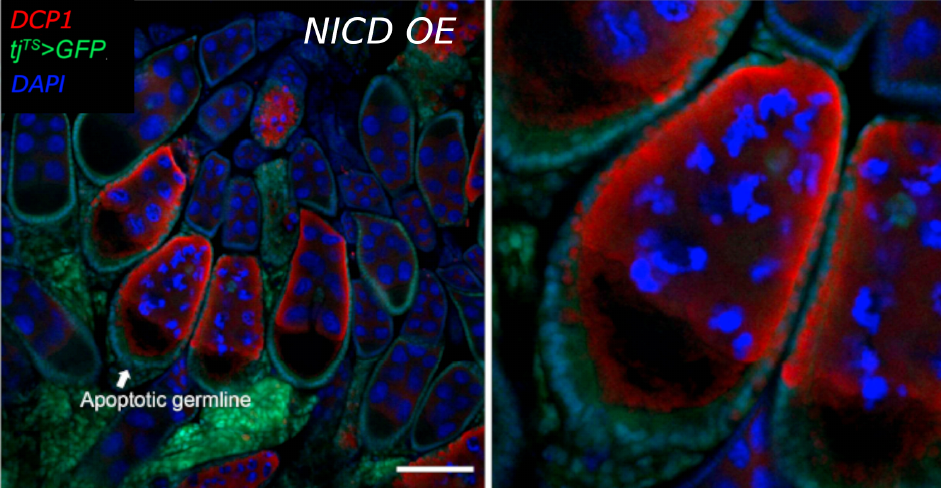
Figure A6. Germline apoptosis occurs following NICD overexpression in follicle cells. Confocal image (left) of an ovary from the NICD OE condition. Follicle cells are marked by expression of GFP driven by tj-Gal4 (green). DCP1 antibody (red) marks apoptosis in the germline (nurse cells and oocyte). DAPI marks nuclei (blue). A single mid-staged egg chamber at the mid-oogenesis checkpoint is shown with apoptotic germline and shown in a close up image at right. Scale bar = 20 µ